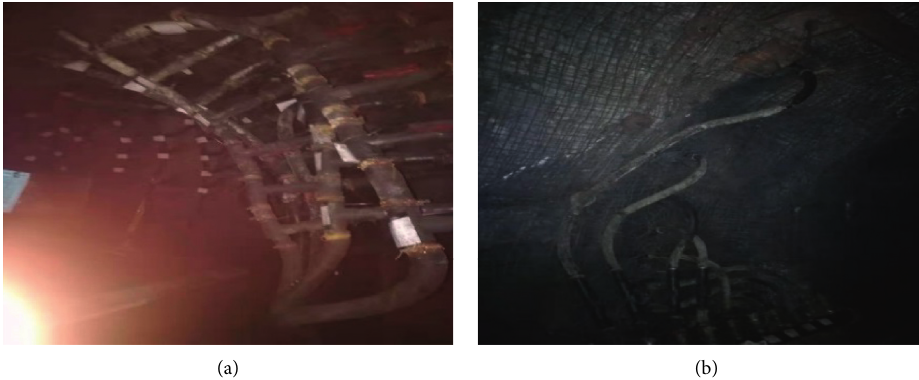
Figure 2: Inclination test site. (a) Drilling site at the early stage of treatment. (b) Drilling at the later stage of treatment.